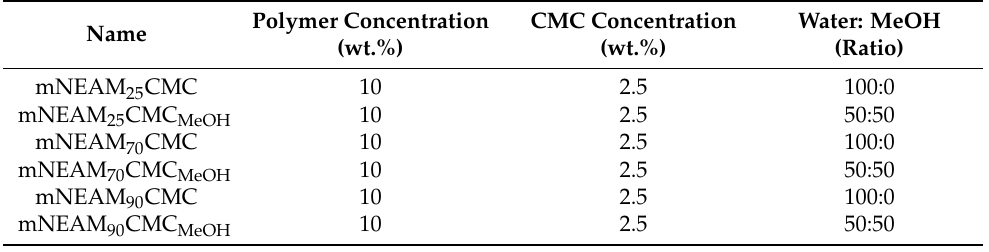
Table 3. Composition of blends composed of polymers and CMC in water and water/methanol